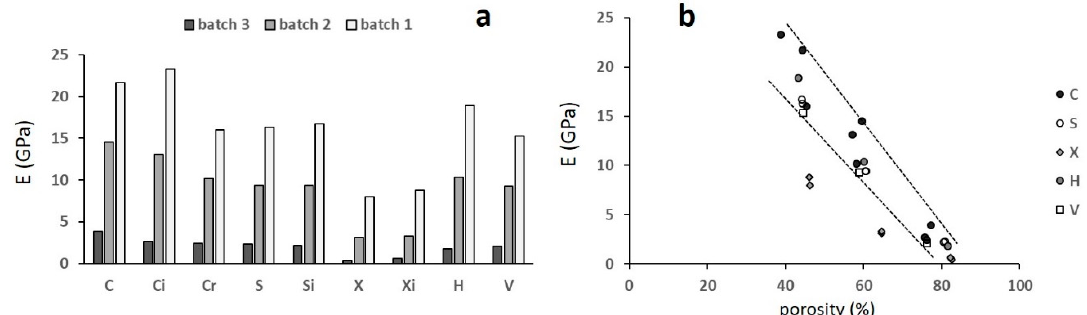
Figure 10. ( a ) The Young’s modulus and ( b ) its correlation with porosity. Scatter ±1 GPa. The letters refer to structures and the dashed lines in ( b ) indicate the width of the scatter.